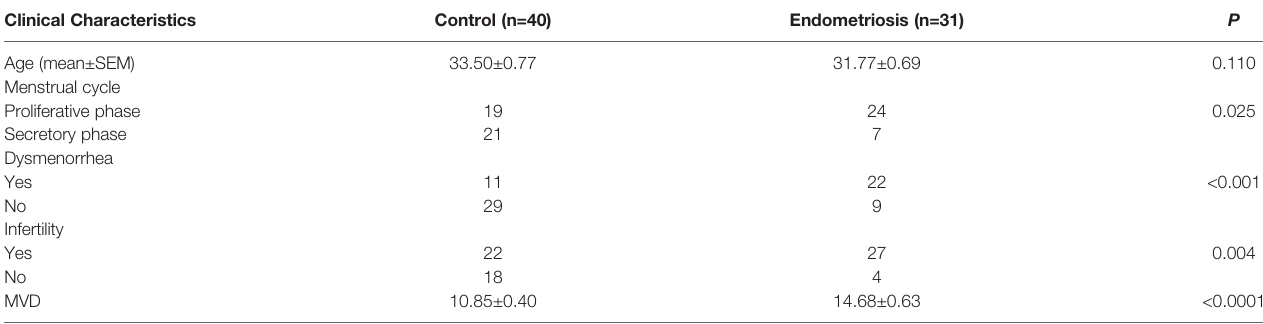
TABLE 1 | Clinical data of patients with endometriosis and without endometriosis (control). Clinical